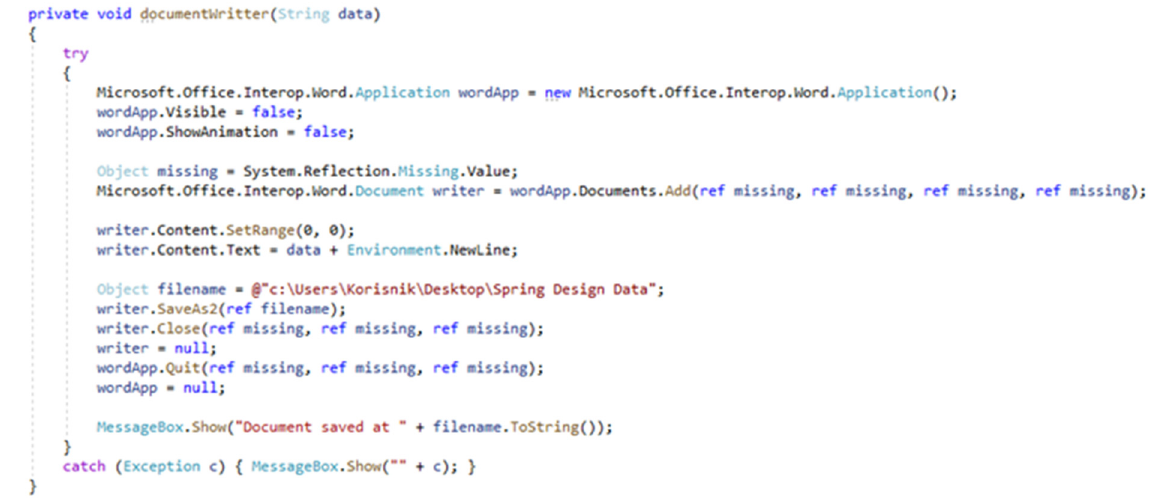
Figure 10. C# code for the “documentWriter”